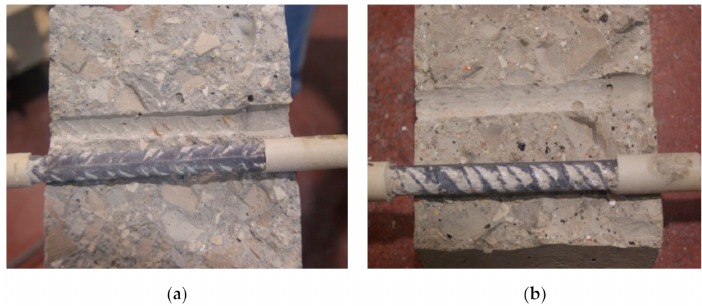
Figure 2. Mobilization of ribs in ( a ) RC and ( b ) C100F-Amb. Unsurprisingly, the percentage variations of bond strength for concrete mixes with RA from CDW (3.9 to 6.0%) are within the range of those found for the decrease of the compressive strength of the concrete mixes (between 3.7% to 4.8%), since in fact most analytical expressions estimate τ max by means of the compressive strength of concrete. Kim and Yun [44] also refer that the prediction of the bond strength by means of the compressive strength of concrete is more appropriate than by means of the tensile strength. Given this, the analytical expressions proposed by Orangun et al. [45] (Equation (2)), Darwin et al. [46] (Equation (3)) and CEB-FIP [47] (Equations (4) and (5)), which were developed for the prediction of bond strengths by means of the compressive strength for natural aggregate concrete, were plotted superimposed with the experimental results obtained in this